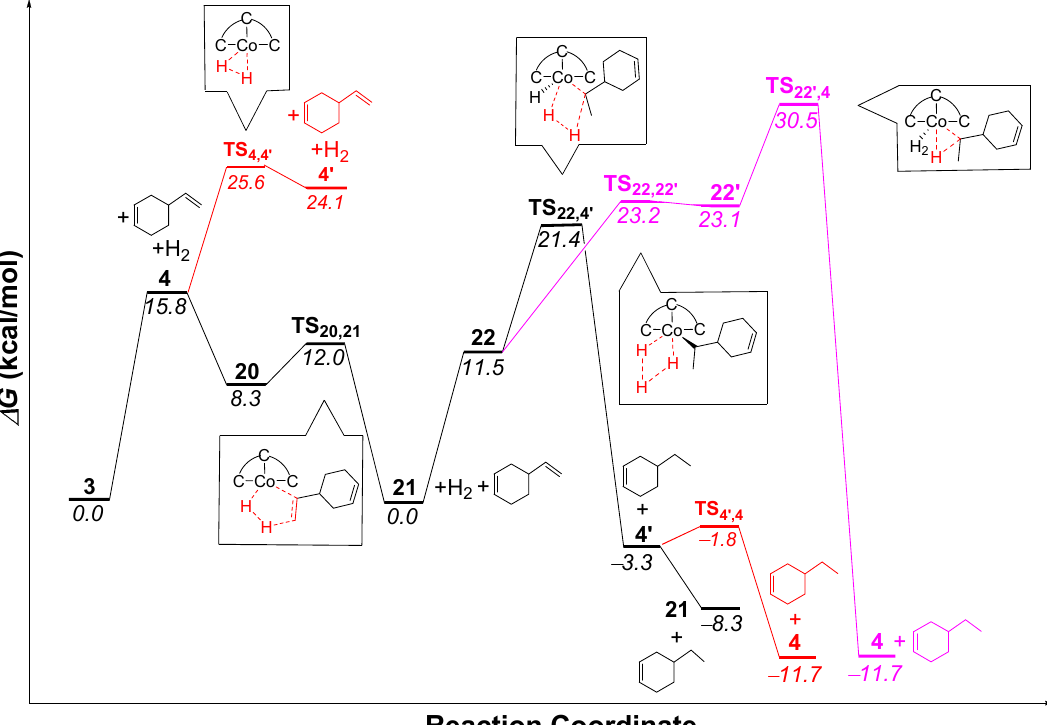
Figure 9. Free energy profile for the hydrogenation of 4-vinylcyclohex-1-ene to 4-ethylcyclohex-1-ene catalyzed by ( Mes CCC)Co complexes.